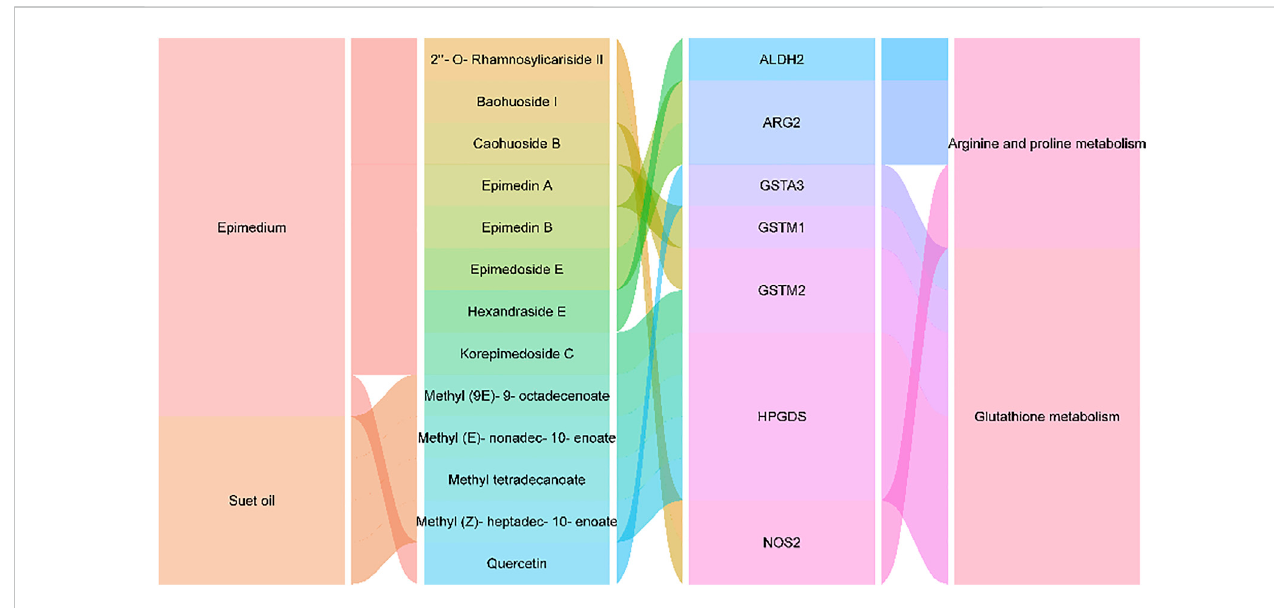
FIGURE 10 The network of drug-active compounds-target genes-pathways.